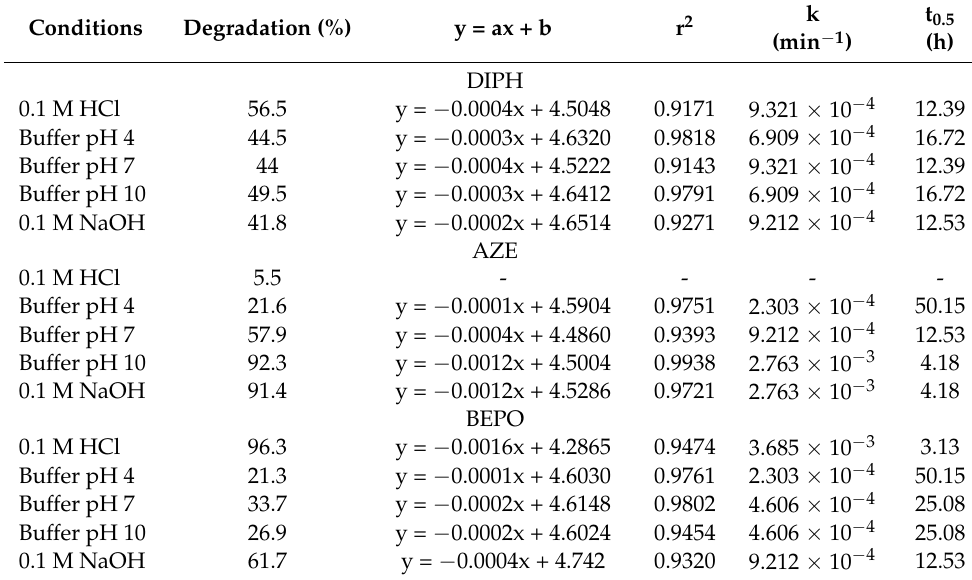
Figure 5. UV spectra of the examined drugs: ( A ) diphenhydramine (DIPH) = 1, violet line, azelastine (AZE) = 2, black line and bepotastine (BEPO) = 3, blue line in methanolic solutions, ( B ) AZE in solutions of pH 10 before irradiation = 1, black line and after irradiation = 2, blue line. Table 3. Photodegradation of diphenhydramine (DIPH), azelastine (AZE) and bepotastine (BEPO) in